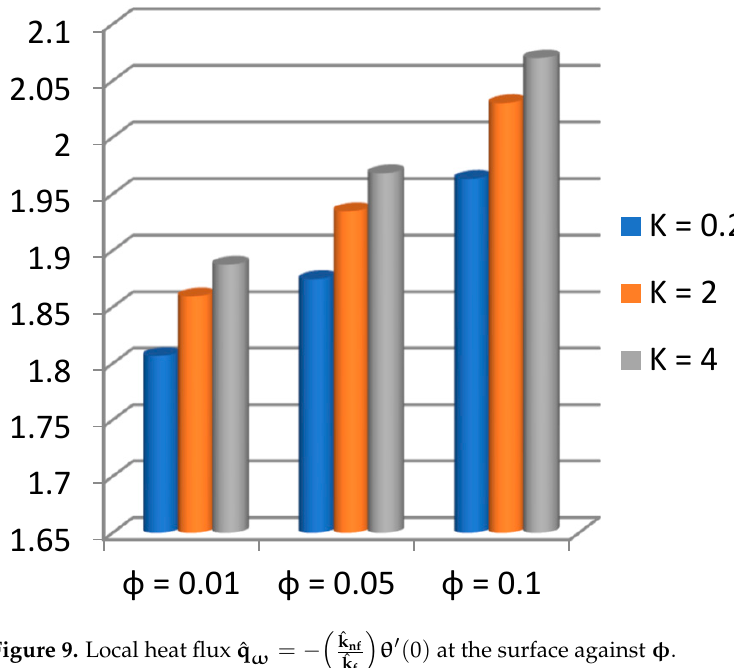
Figure 8. Magnitude of shear stress (cid:4678) 𝟏 against 𝛟 .